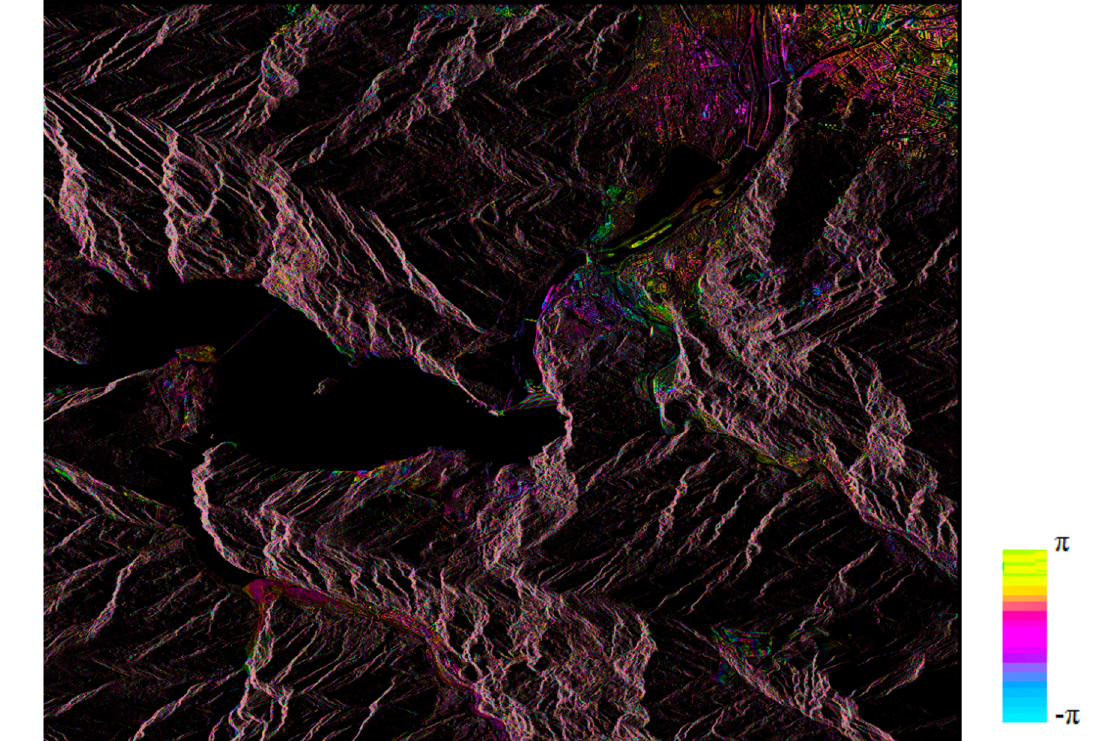
Figure 6. The interferogram between 10/08/2016 and master 25/07/2016 SLC after flattening and filtering in the radar coordinate system, the base map is the amplitude of the interferogram complex data; the phase is superimposed on the base map. The fringes can be clearly seen on the bridge, buildings (top − right), road, and dam areas in the figure. The fringes of the dam area in the red rectangle box can be seen in Figure 7 more clearly after flattening and filtering in the radar coordinate system. The fringes over the dam areas are displayed in more detail in Figure 7 below.